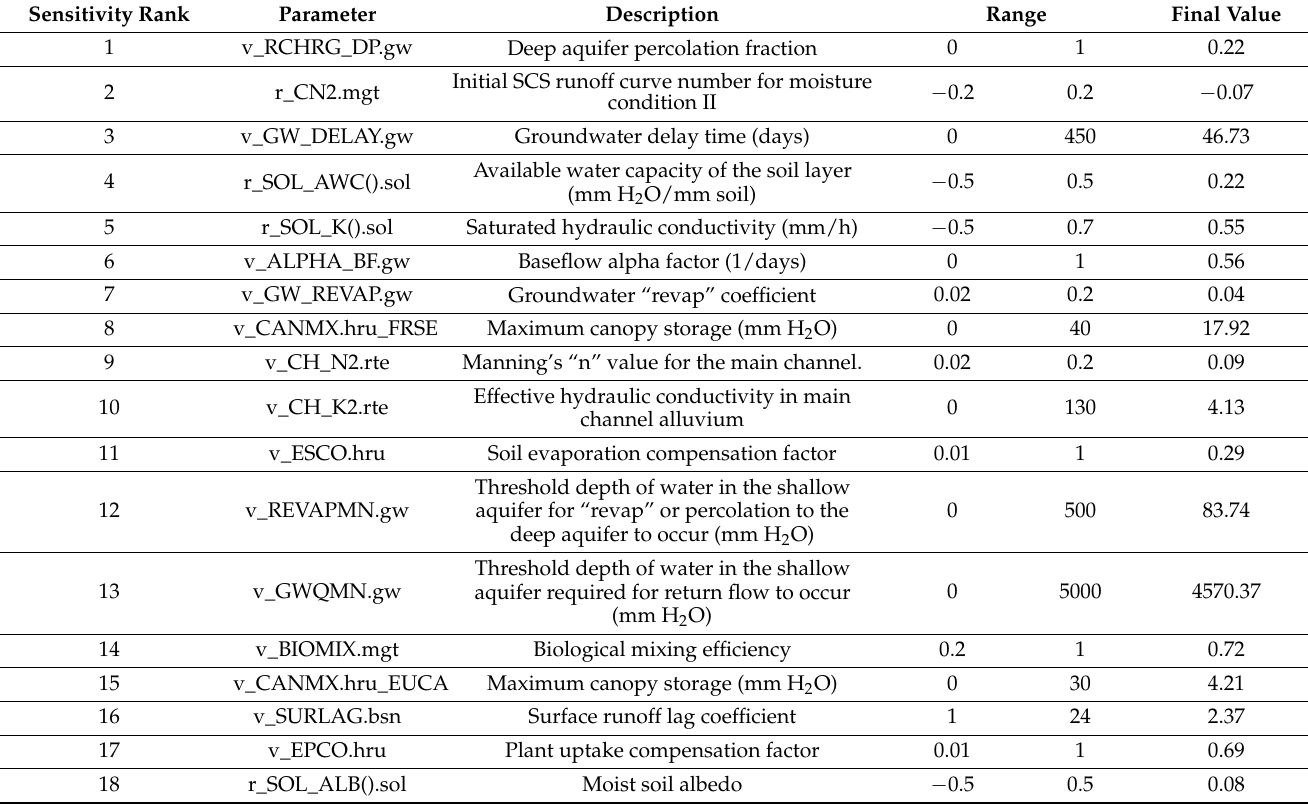
Table 2. Description and values for the eighteen parameters assessed during model calibration.